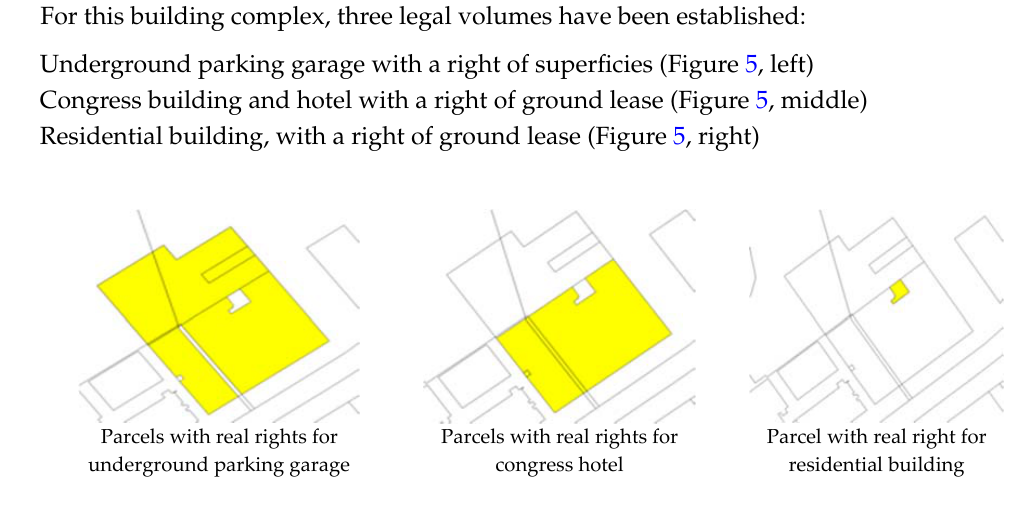
Figure 5. 2D parcel map around the Congress hotel in the Amsterdam case